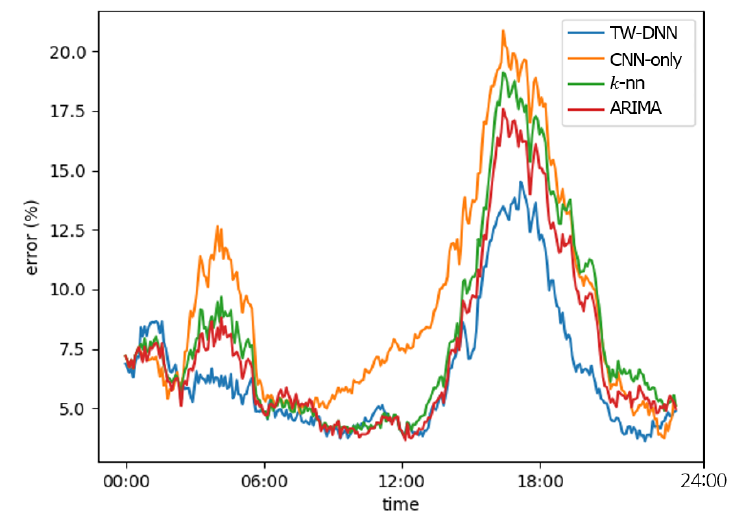
Figure 12. MAPE error of prediction models for Case III.